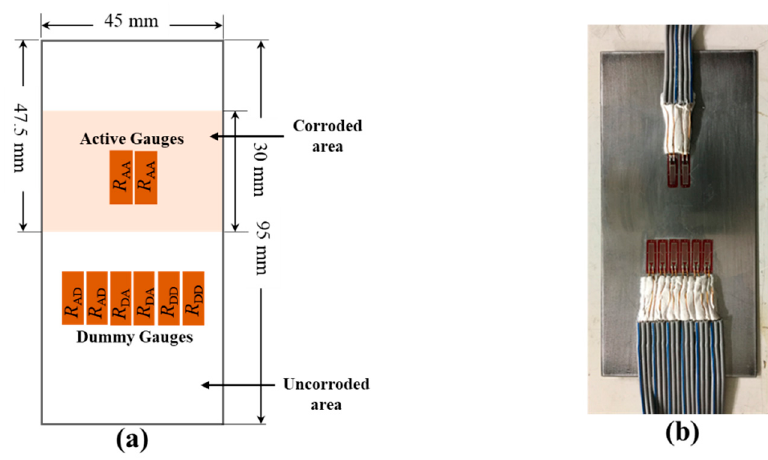
Figure 4. ( a ) Configuration of strain gauges in test piece with 1350 mm 2 corroded area; the remaining area is not corroded. ( b ) Photograph of strain gauge attached to the test piece.